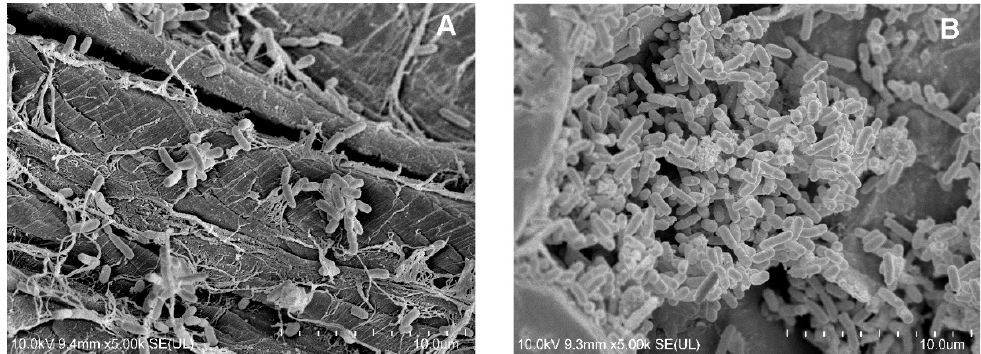
Figure 6. SEM microphotographs of Stenotrophomonas maltophilia KB2 cells immobilized in optimal conditions at 4 ( A ) and 15 ( B ) cultivation days. The working distance was 9.4 mm and 9.3 mm for the ( A ) and the ( B ) microphotographs, respectively.